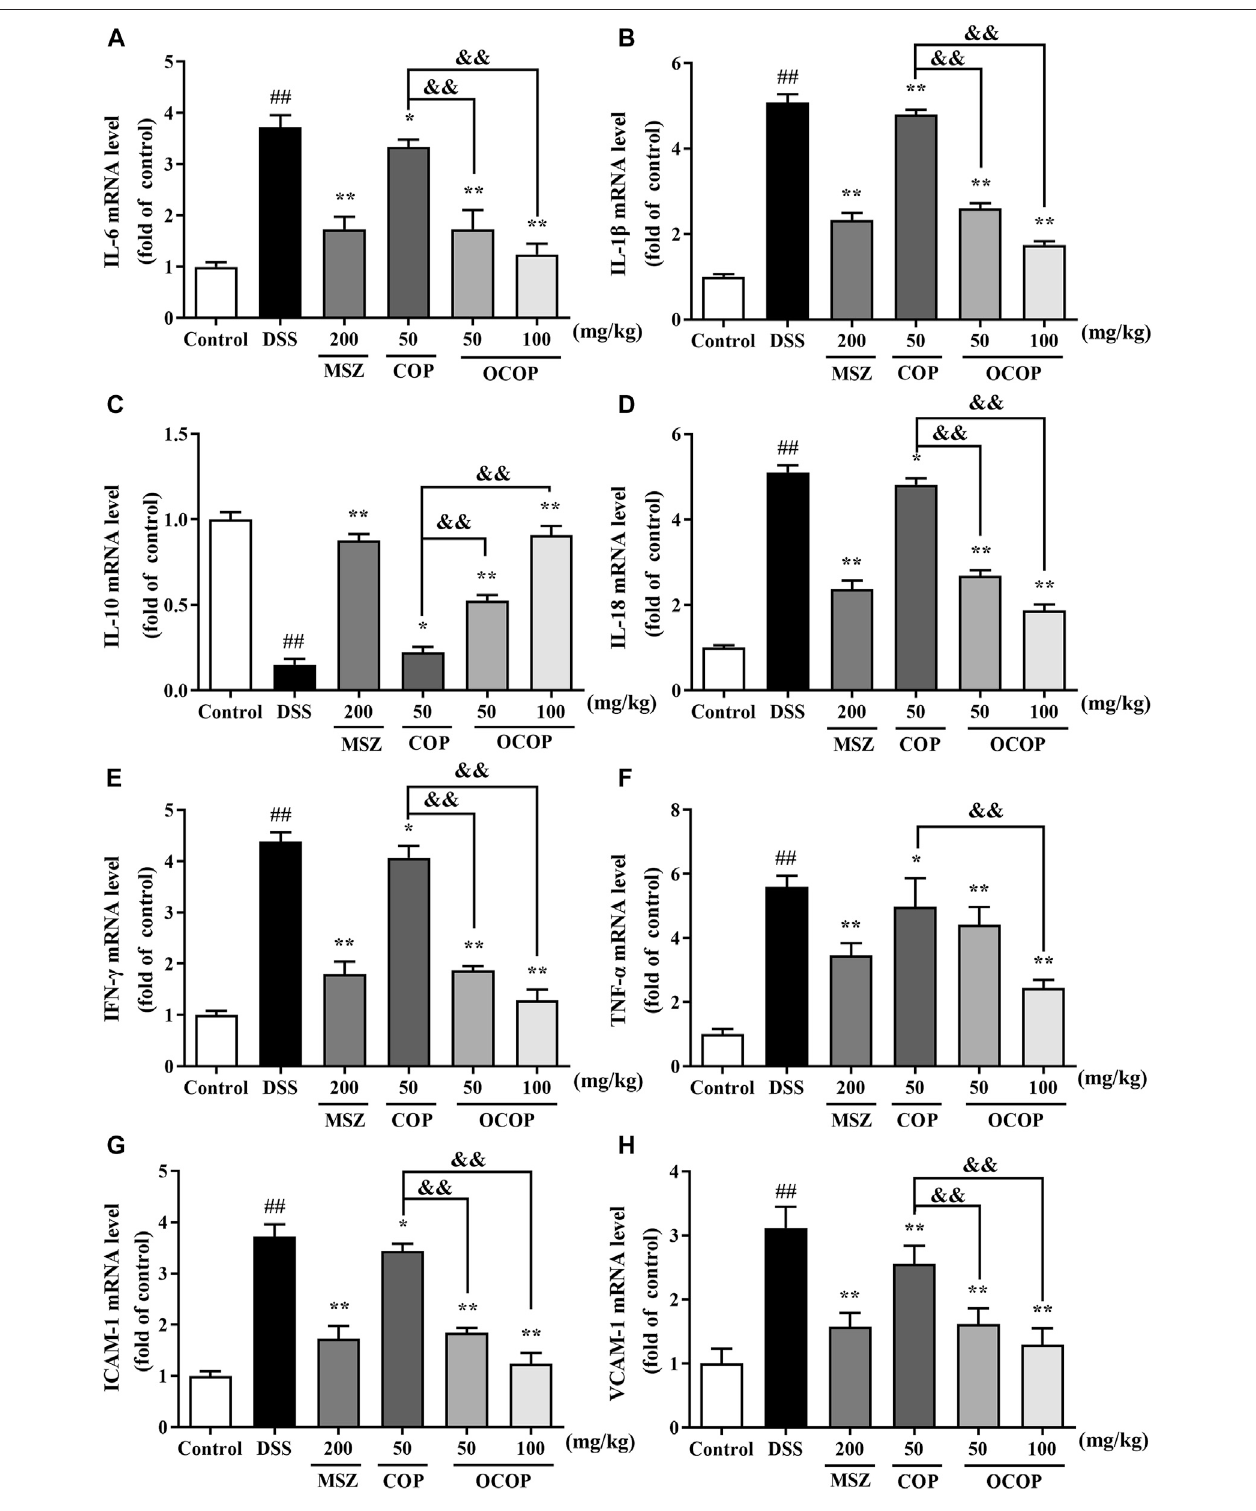
FIGURE 5 | The mRNA expression levels of IL-6 (A) IL-1 β (B) , IL-10 (C) , IL-18 (D) , IFN- c (E) , TNF- α (F) , ICAM-1 (G) , VCAM-1 (H) in mice as determined by qRT- PCR.Dataareexpressed asthemeans ± SD(n (cid:2) 10). # p < 0.05, ## p < 0.01vs.controlgroup;* p < 0.05,** p < 0.01vs.DSSgroup; & p < 0.05, && p < 0.01vs.COPgroup.